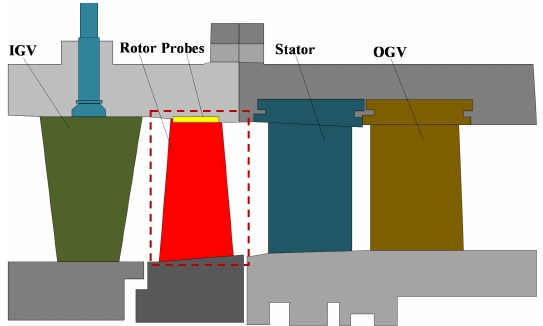
Figure 1. Schematic structure of the 1.5-stage